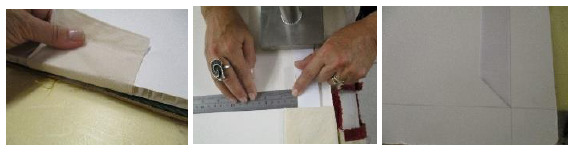
Figure 19 - Three moments of applying the Velcro strips on the back of the panels.